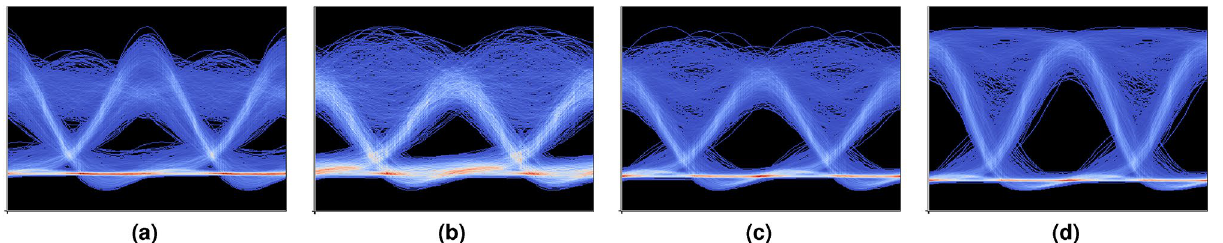
Figure 5. Eye diagrams for different readout schemes and with different nonlinearities. ( a ) Unequalized, ( b ) equalized by electrical readout, ( c ) equalized by optical readout and ( d ) equalized by optical readout utilizing both photodetector nonlinearity and voltage amplifier